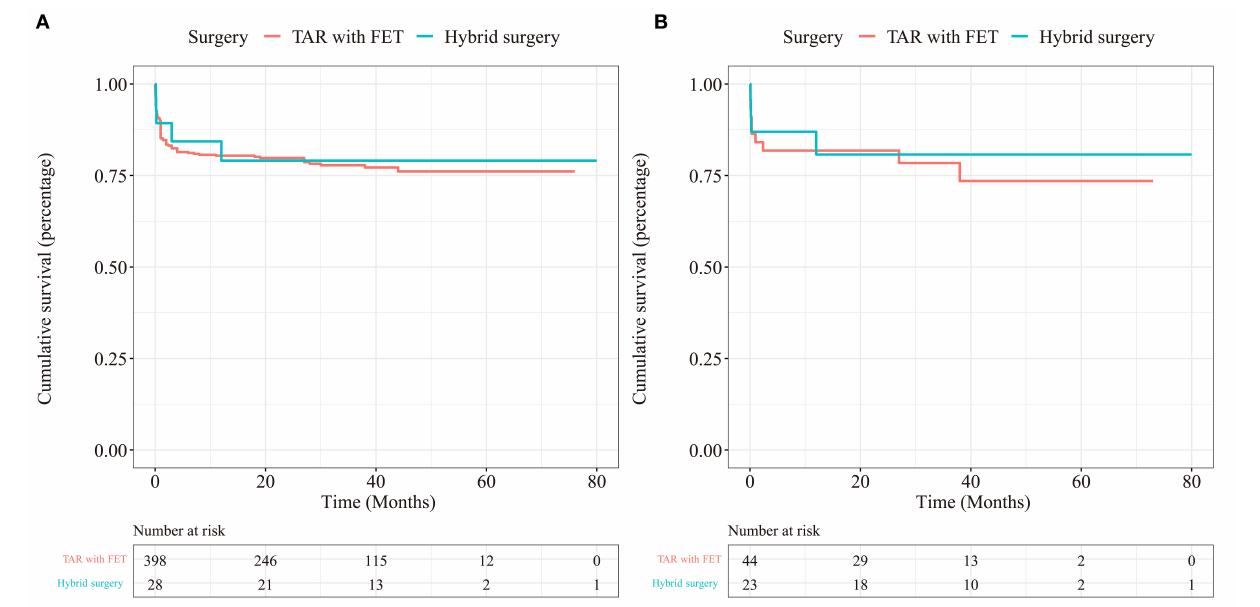
FIGURE 2 | Kaplan-Meier survival curve for TAR with FET and hybrid surgery in the overall cohort (A) and in the PSM cohort (B) .